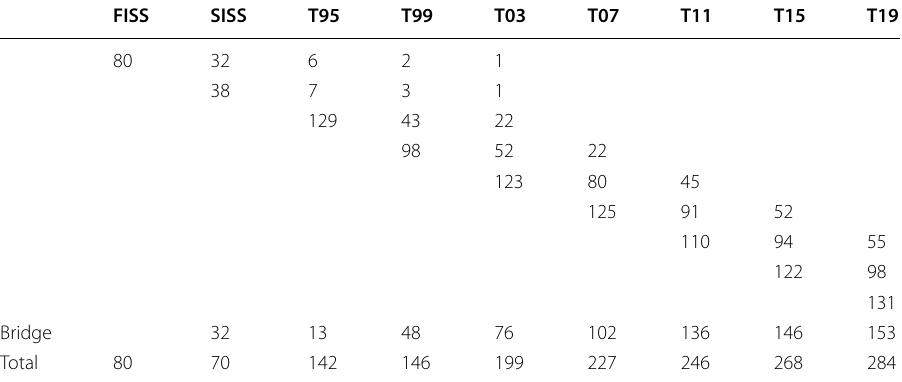
This table shows item overlaps across the assessments over time. The same logic applies as in Table